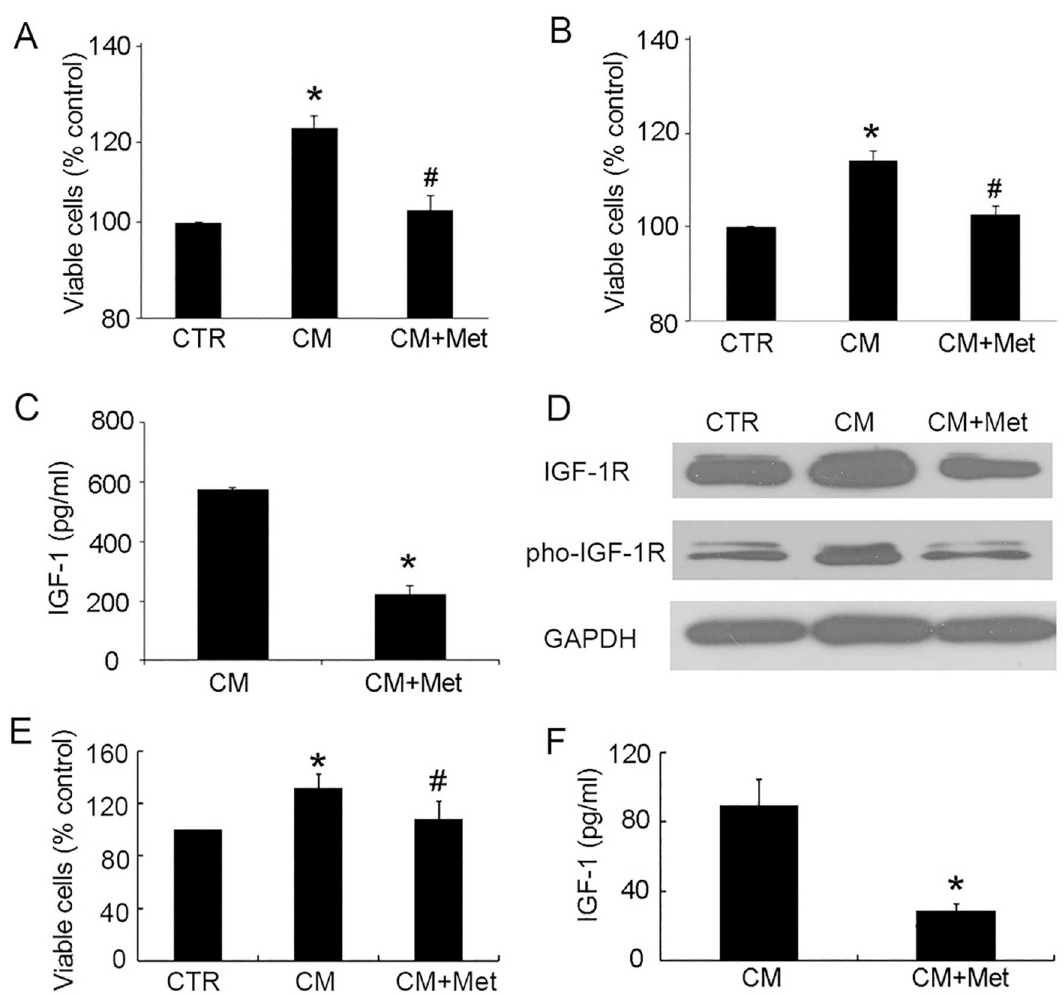
Fig 6. Metformin interrupts the effect of stromal cells on epithelial cells. A-B: The cell viability of BPH-1 (A) and P69 (B) was markedly enhanced with conditioned medium of 3T3 fibroblast cells, and was abrogatedby 5 mM metformin. C: Metformin (5 mM, 24 h) inhibitedthe secretion of IGF-1 in 3T3 cells. D: Immunoblots of IGF-1R and pho-IGF-1R in BPH-1 cells treated with CM of humanprostatic fibroblast. E: The BPH-1 cell viabilityafter treatment with CM of human prostatic fibroblast. F: Metformin (5 mM, 24 h) inhibitedthe secretion of IGF-1 in humanprostatic fibroblasts. * , P < 0.05compared with the control (CTR) group; #, P < 0.05comparedwith CM-treated group. CTR: non-treatedcontrol, Met: